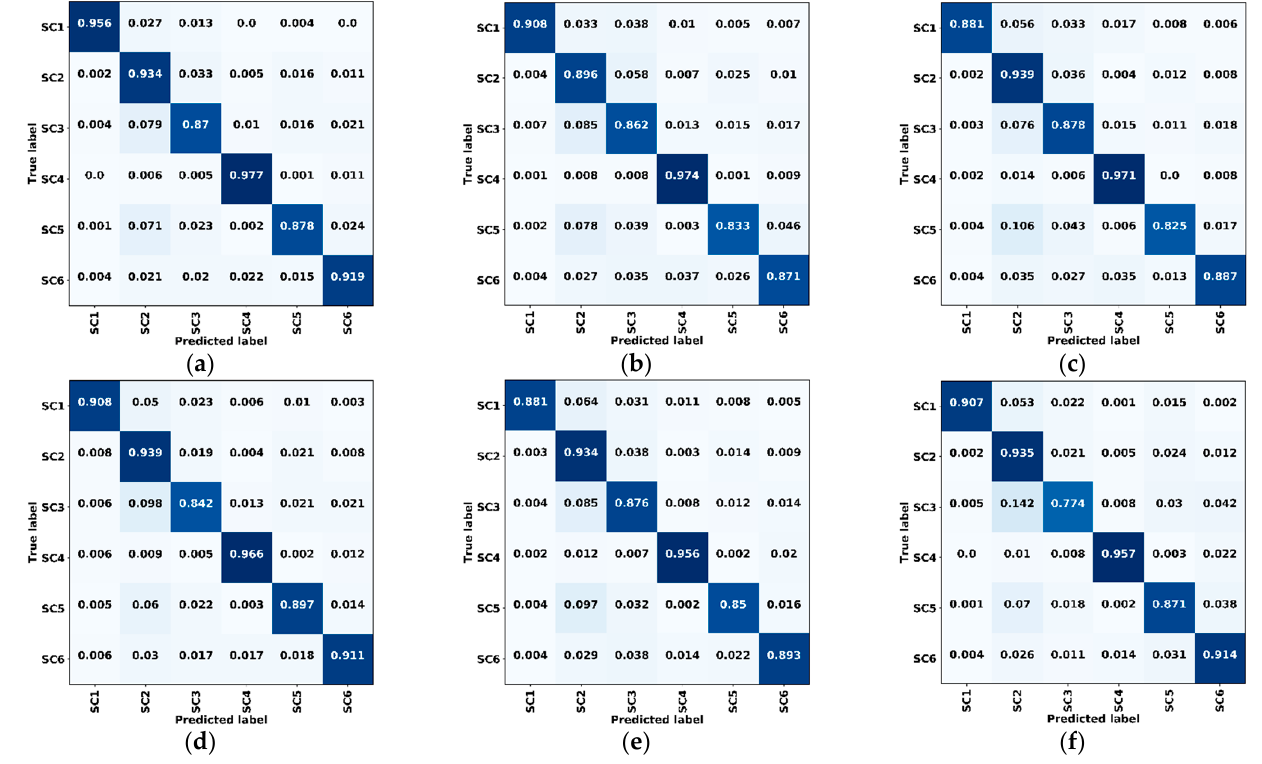
Figure 10. Confusion matrices of validation data for dataset A. ( a ) ResMANet. ( b ) U-Net. ( c ) PSPNet (ResNet-50). ( d ) DeepLabv3+ (ResNet-50). ( e ) U-Net (ResNet-50). ( f ) ResMANet (CEL). SC1: Farmland, SC2: Woodland, SC3: Grassland,